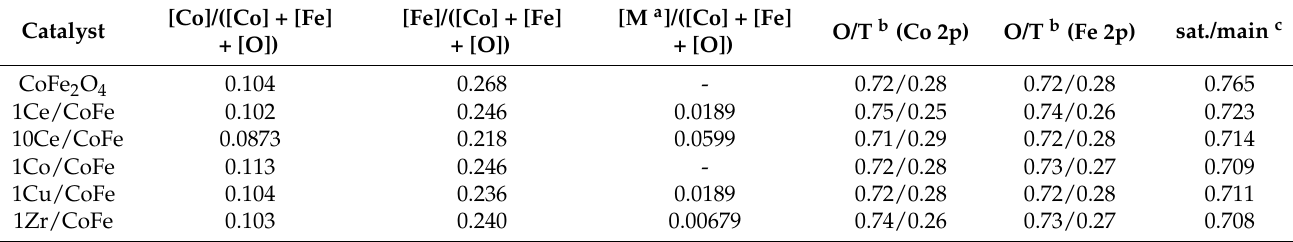
Table 2. Ratios extracted from quantitative analysis of the XPS fitted spectra. Atomic sensitivity factors employed to determine atomic ratios were taken from Wagner et al.